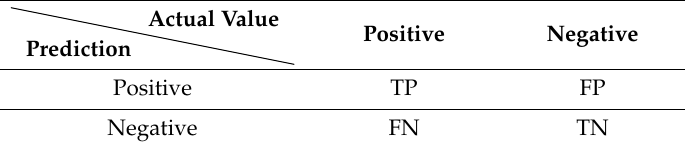
Table 4. The definitions of TP, TN, FP and